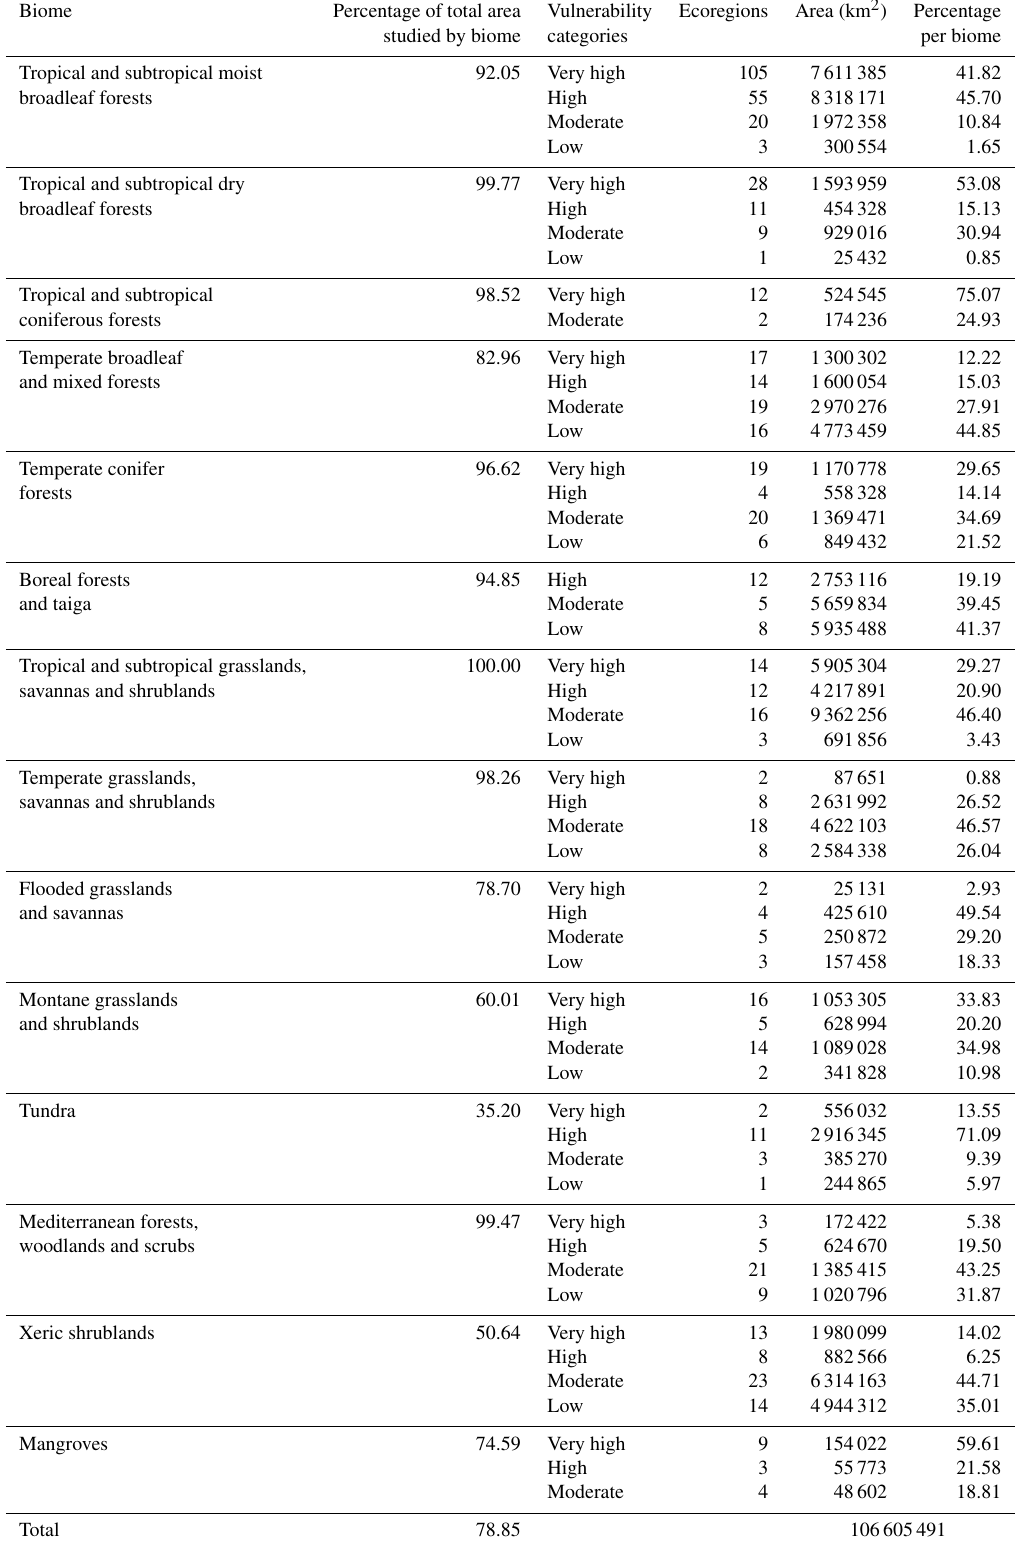
Table 11. Number of ecoregions, surface area and percentage of land ecologically vulnerable to fires. Biome Tropical and subtropical moist